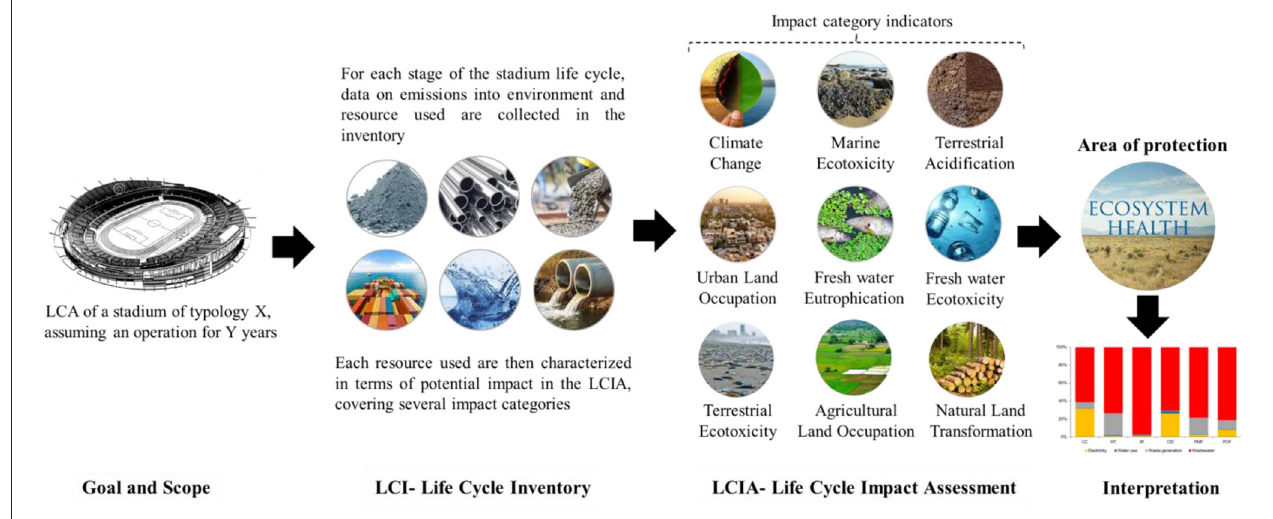
FIGURE 1 | Stages and process in life cycle assessment of RAA